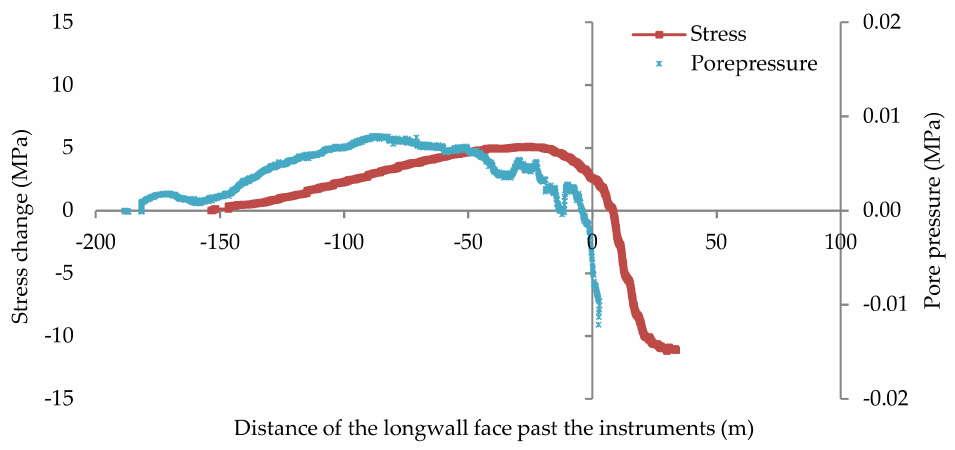
Figure 10. Corresponding changes of strata stress and pore pressure monitored at LW